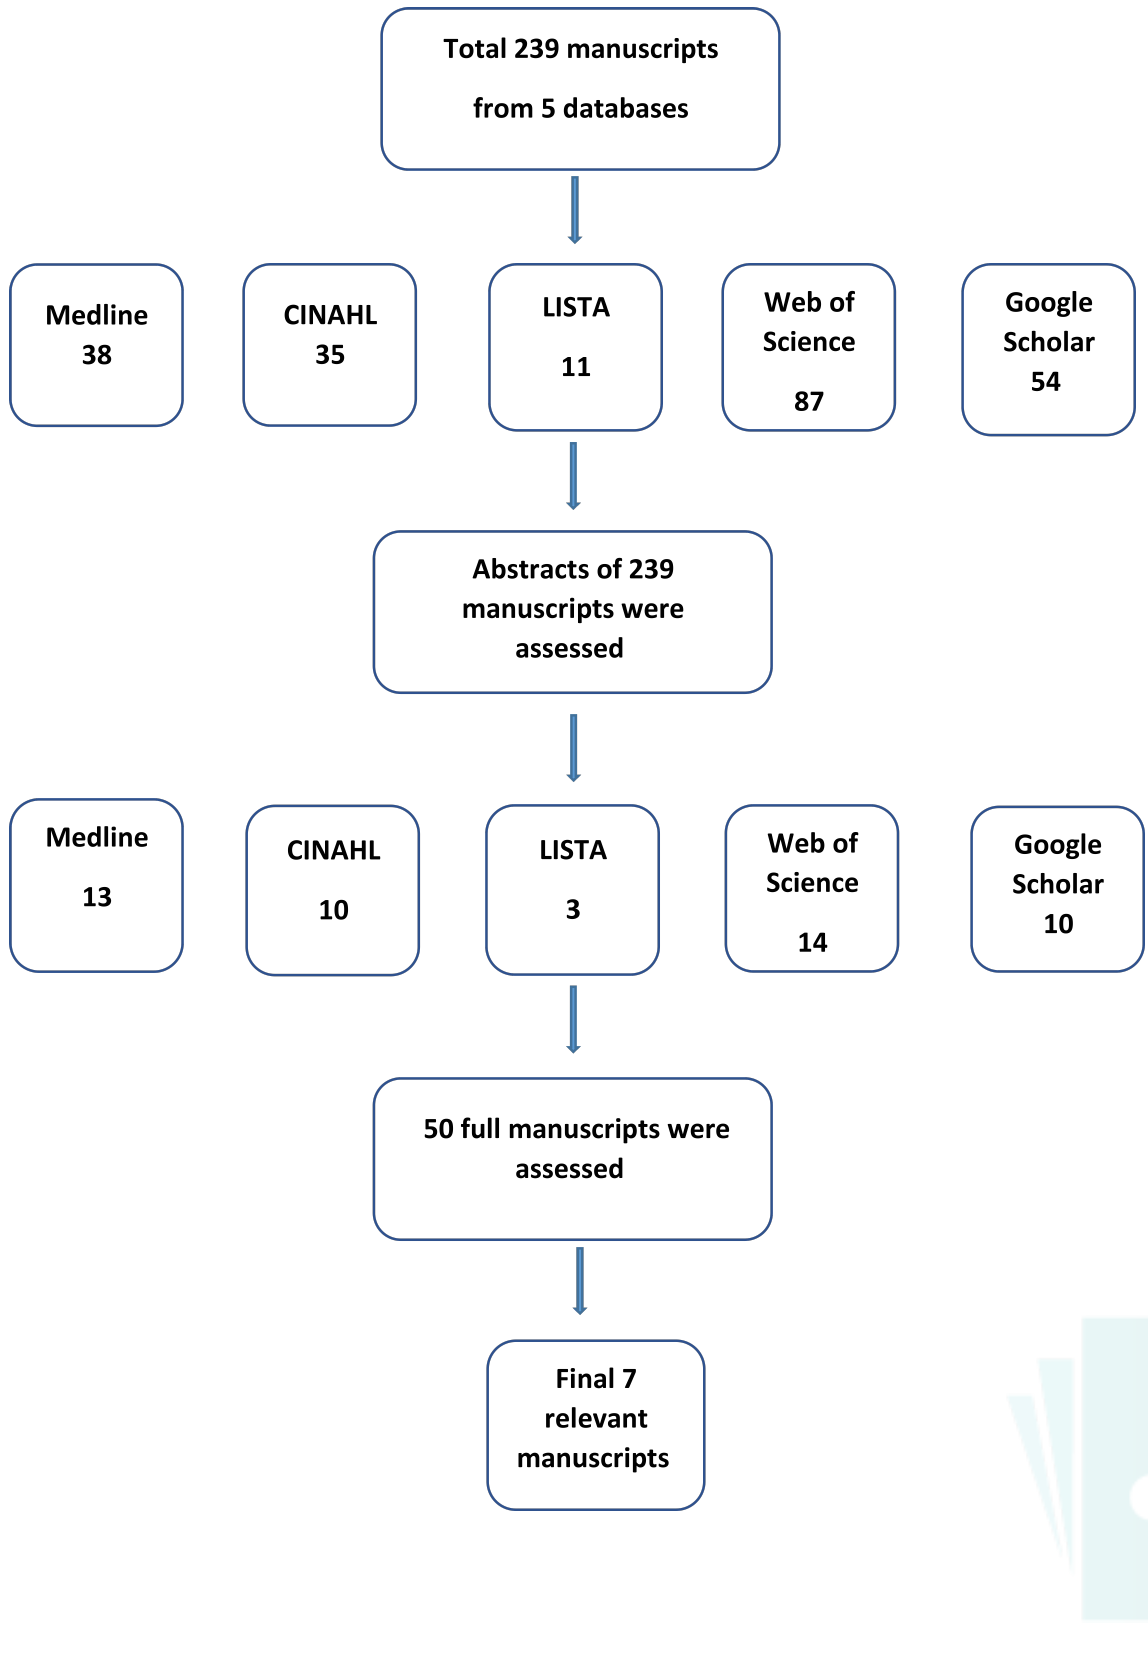
Figure 1: Overview of the steps taken in the priority-setting